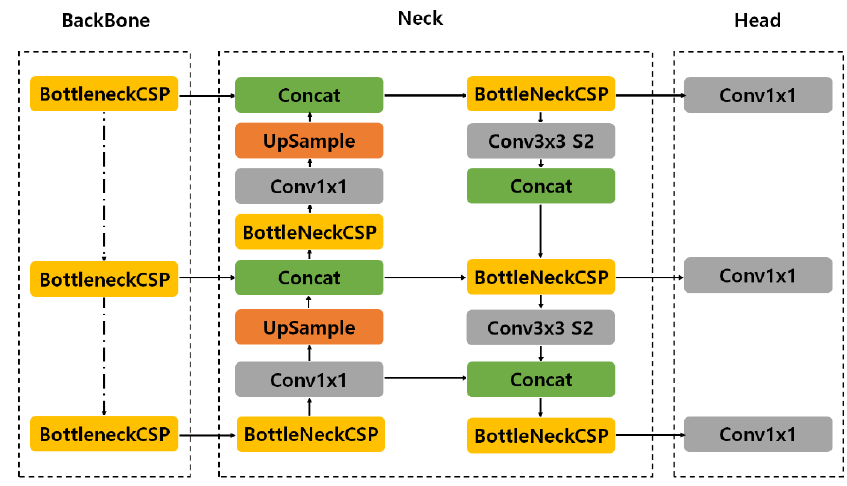
Figure 9. Structure of YOLOv5.